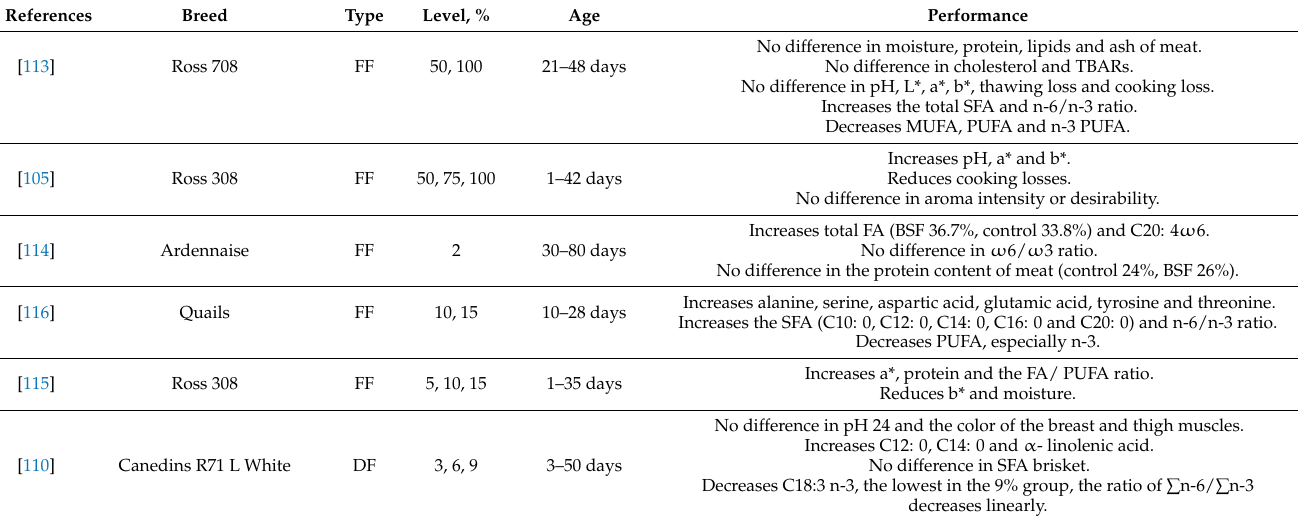
Table 7. Effects of BSFL on the meat quality and nutritional content of